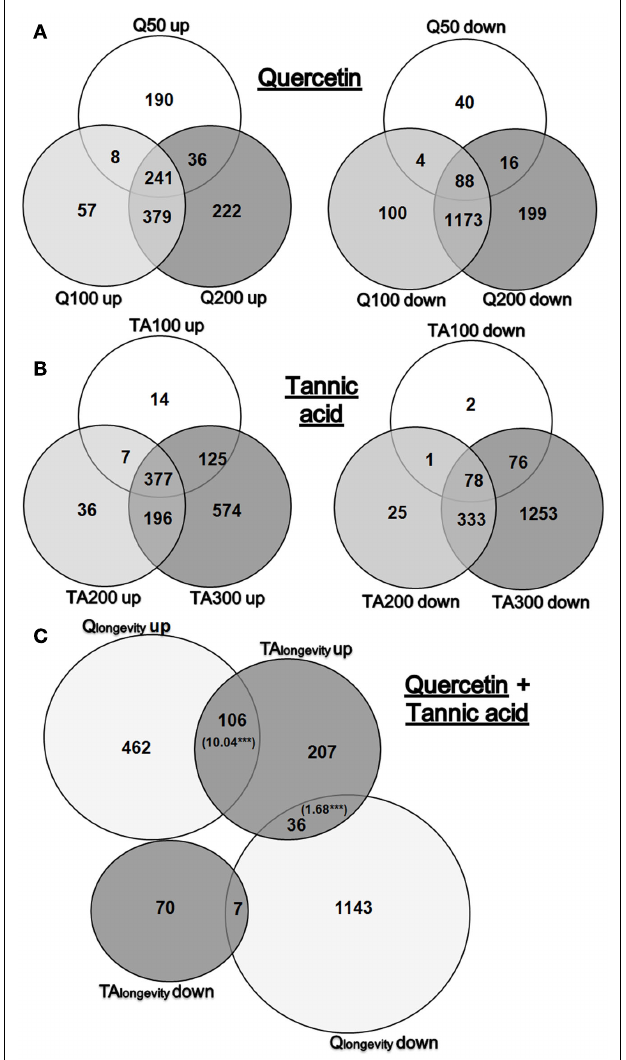
FIGURE 1 |Venn diagrams of DEGs. Overview of significant DEGs (fold change > 1.25 or < 0.8) in response to Q50, Q100, Q200 orTA100,TA200, TA300. Shown is the overlap of either up- or down-regulated genes in Q (A) orTA (B) treated nematodes. (C) Displays the overlap of significantly up- and down-regulated genes in Q longevity andTA longevity .The bracketed numbers in the intersections display significant overrepresented RFs, ∗∗∗ p <